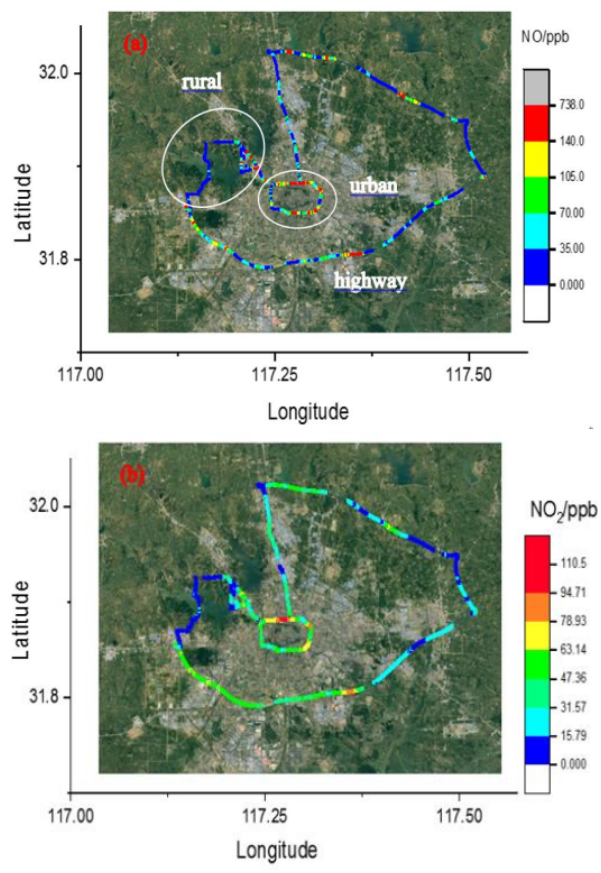
Figure 12. The 4h drive around Hefei, China, coloured by the mea- sured NO (a) and NO 2 (b) concentrations,